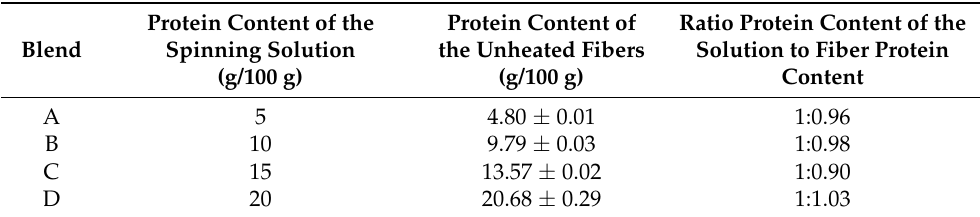
Figure 2. Scanning electron microscopy images showing defects of the electrospun fibers of the different blends ( A ) (80:10:5), ( B ) (80:10:10), ( C ) (80:10:15) and ( D ) (80:10:20) before thermal treatment. The scale bar represents 10 µm. Table 2. Protein content of the spinning solution compared to the protein content in the unheated fiber for the different blends with standard